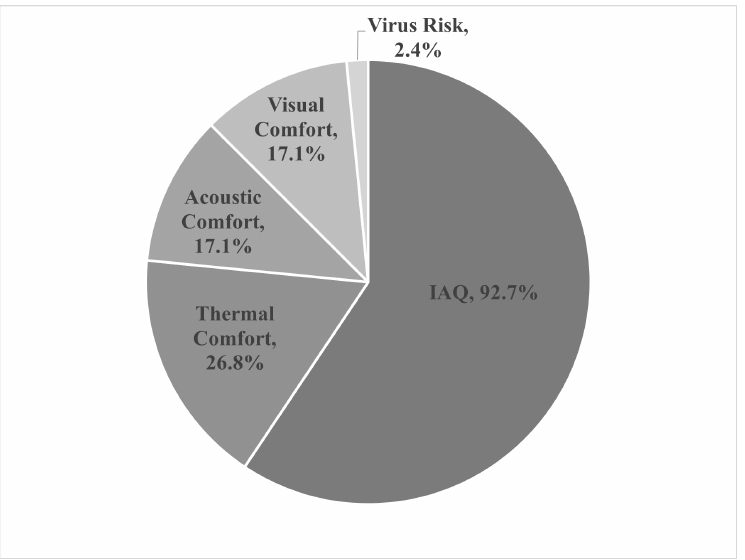
Figure 7. IEQ influencing factor statistics for the selected field measurement